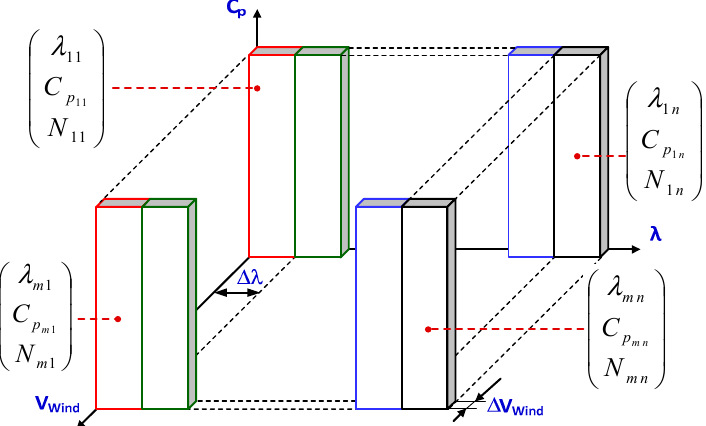
Figure 5. Description of the data classification in V wind and λ ranges before the averaging and weighting process.